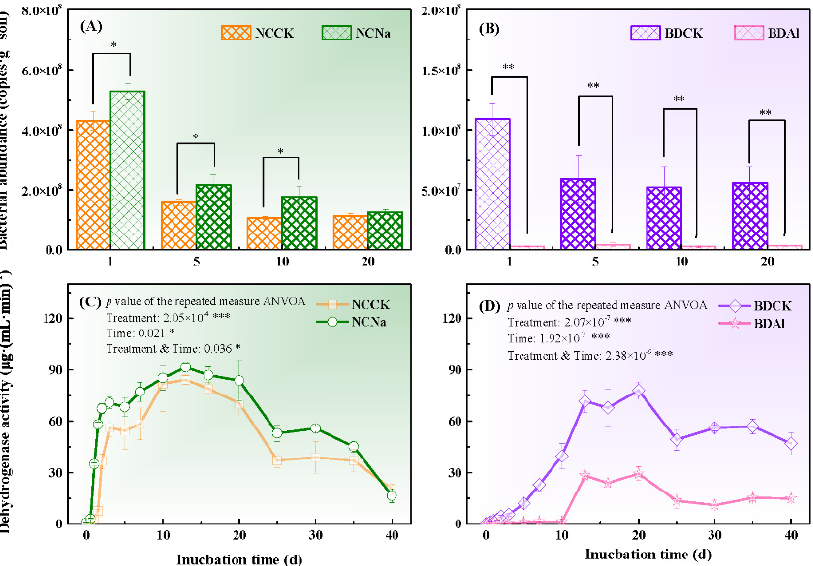
Figure 1. Variation in bacterial abundance ( A , B ) and dehydrogenase activity ( C , D ) during flooding of paddy soils with different initial pH levels (NCCK, the original NC soil without pH adjustment; NCNa, NC soil with pH adjustment to alkaline level; BDCK, the original BD soil without pH adjust- ment; BDAl, BD soil with pH adjustment to acidic level. Numbers following the treatments repre- sented the flooding time. *, indicates significant difference at p < 0.05. **, indicates significant differ- ence at p < 0.01. ***, indicates significant difference at p < 0.001. The same